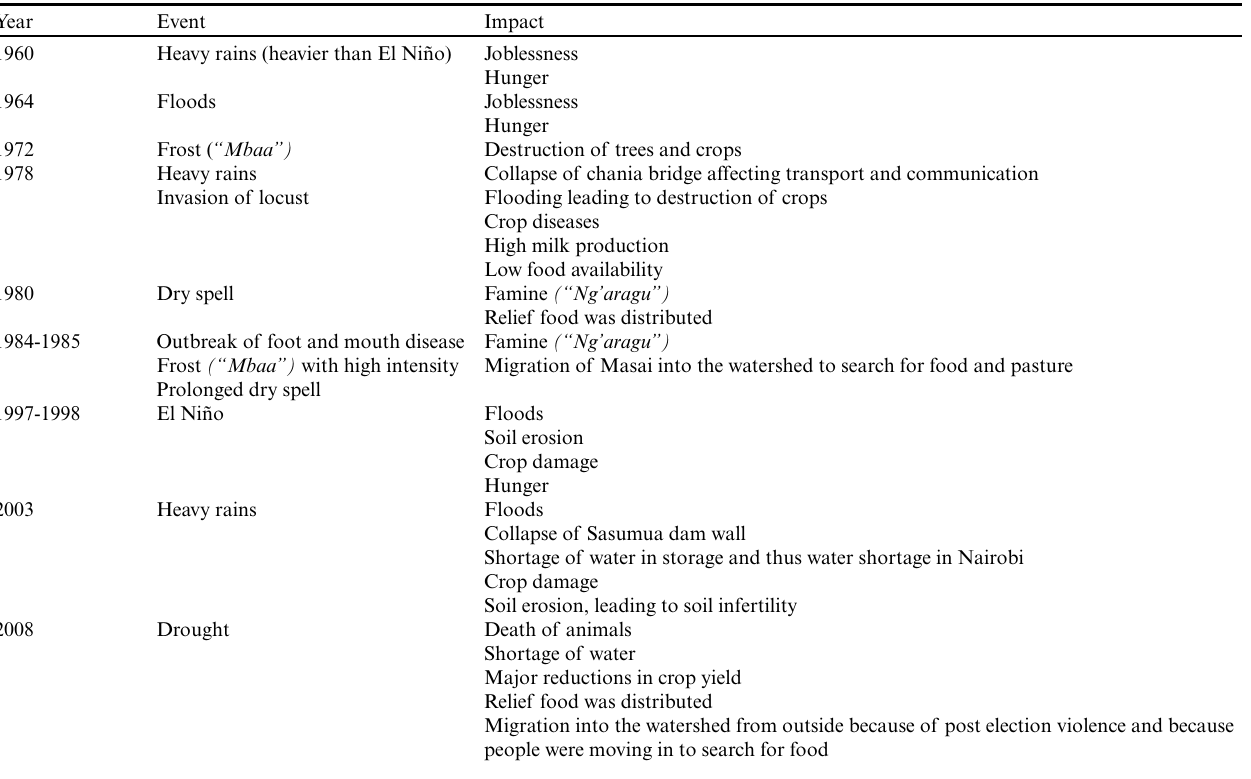
Table 1 . Climate related events and their impacts identified by farmers during timeline